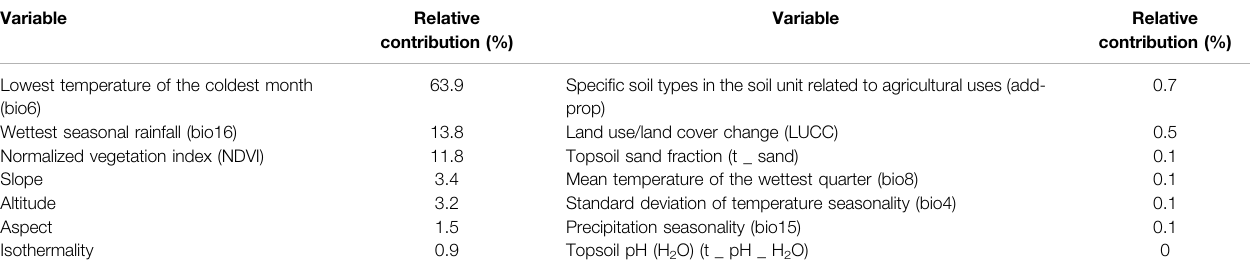
TABLE 3 | Proportional contributions of environmental predictors on the possible spatial distribution of C. appendiculata in China. Variable Relative contribution